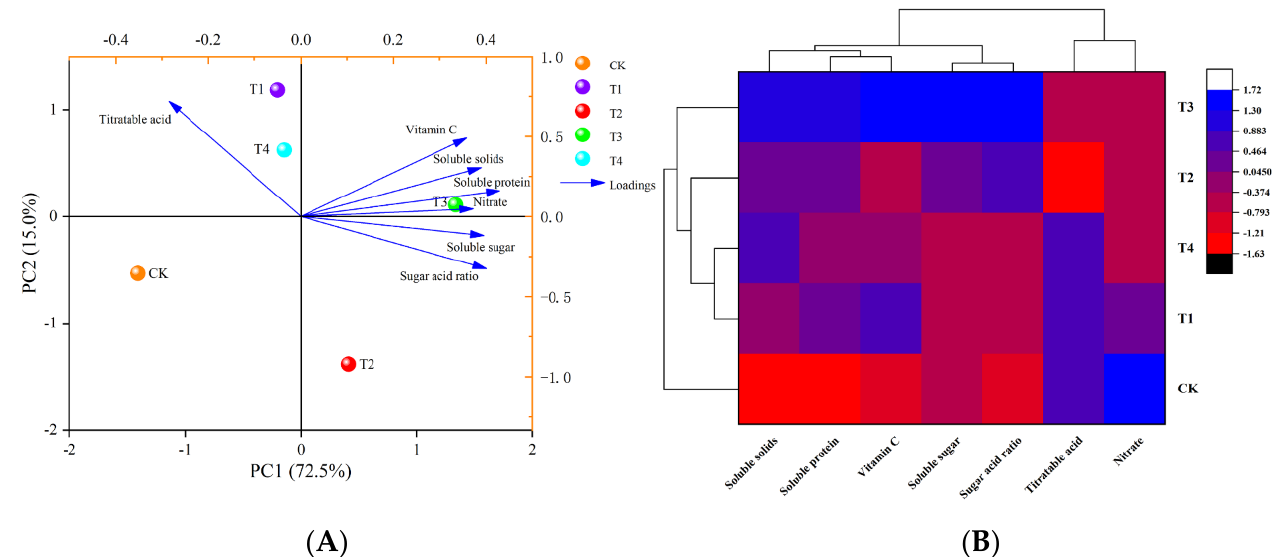
Figure 6 . Principal component analysis ( A ) and cluster analysis ( B ) of the nutritional quality of tomato fruit under different levels of water deficit. The abbreviations CK, T1, T2, T3, and T4 are defined in the footnote of Table 1.